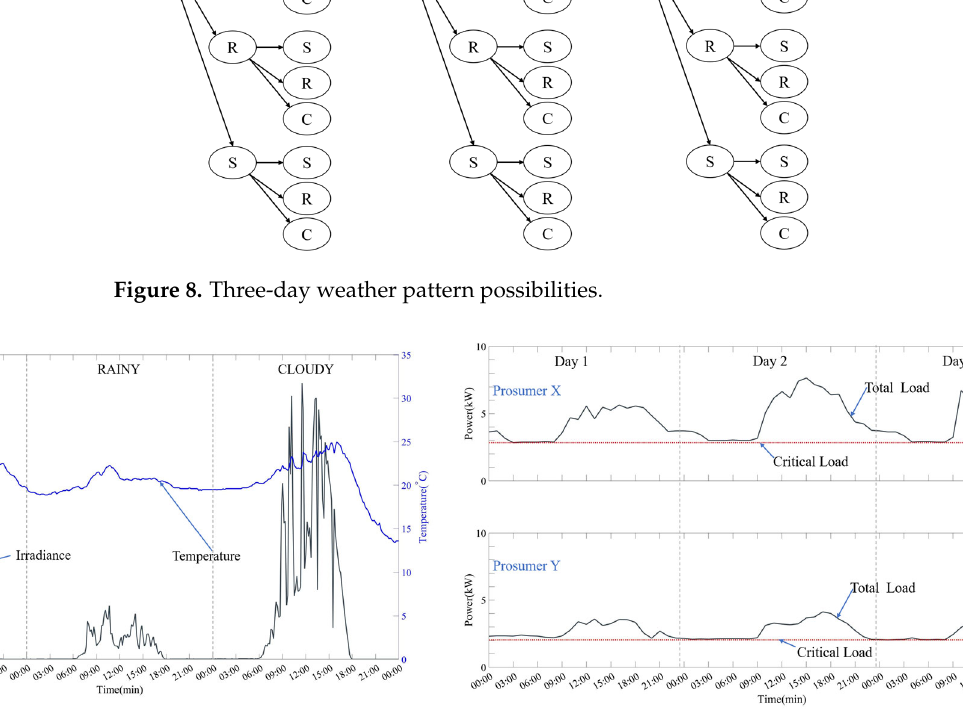
Figure 9. ( a ) Three ‐ day weather data. ( b ) Three ‐ day load profiles. Table 4. Summary of test cases.